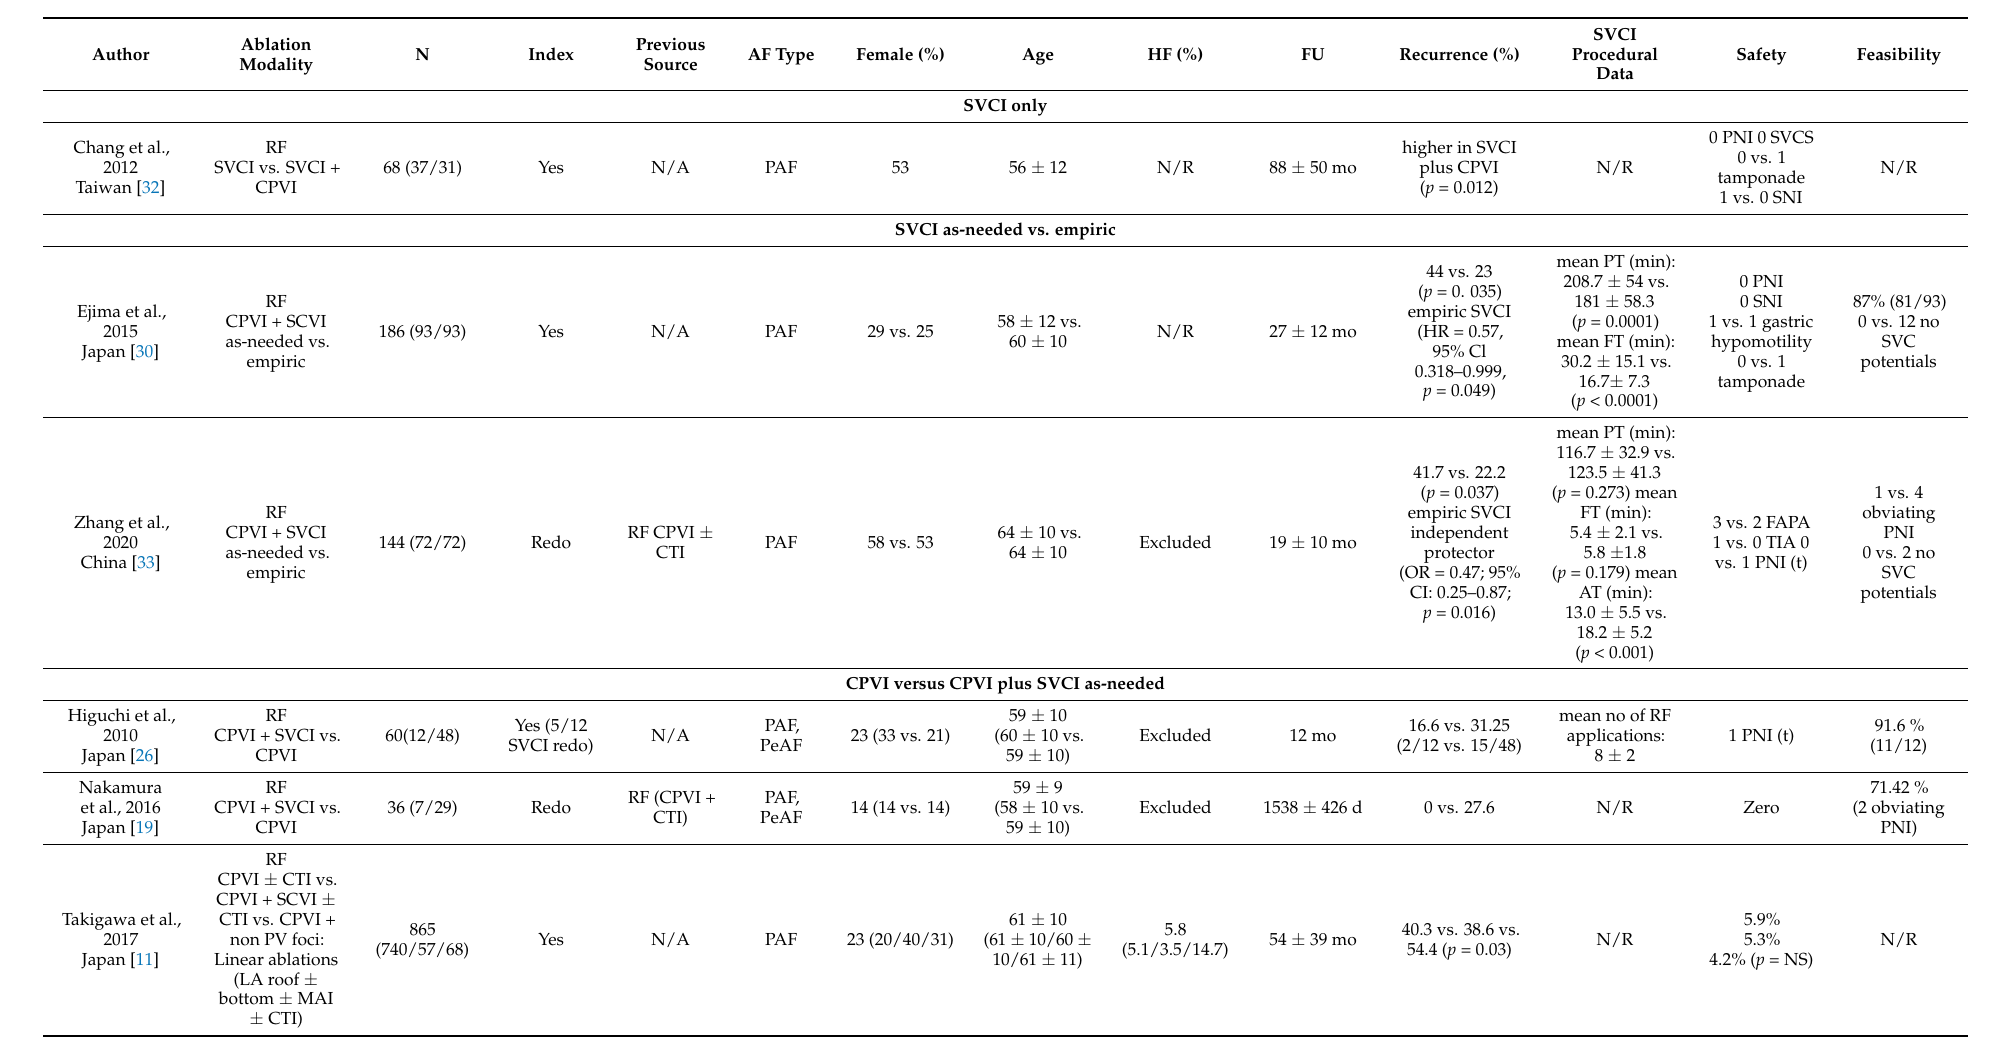
Table 2. Cohorts comparing different superior vena cava isolation approaches in patients with atrial